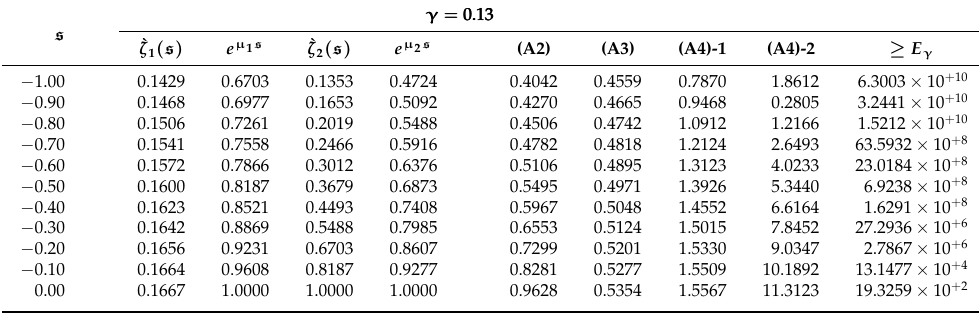
Table 2. Numerical results of (A1)-(A4) of the Gilpin–Ayala predator-prey system with harvesting terms (24) whenever γ = 0.13.